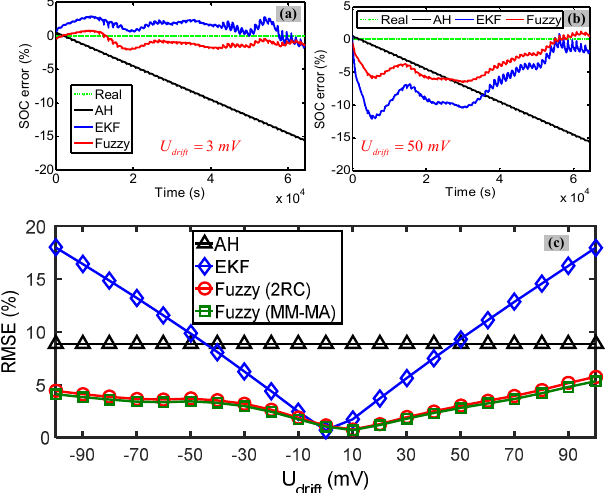
Figure 13. SOC estimation results for Case B. ( a ) ECM drift = 50 mV; ( b ) ECM drift = − 2 mV; and ( c ) RMSE of SOC in different model errors.